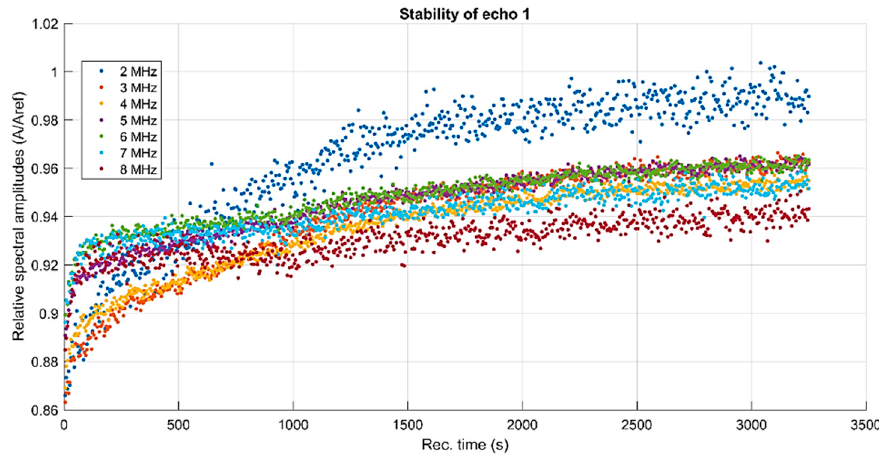
Figure 3. Spectral amplitudes relative variation vs. time for the first echo.